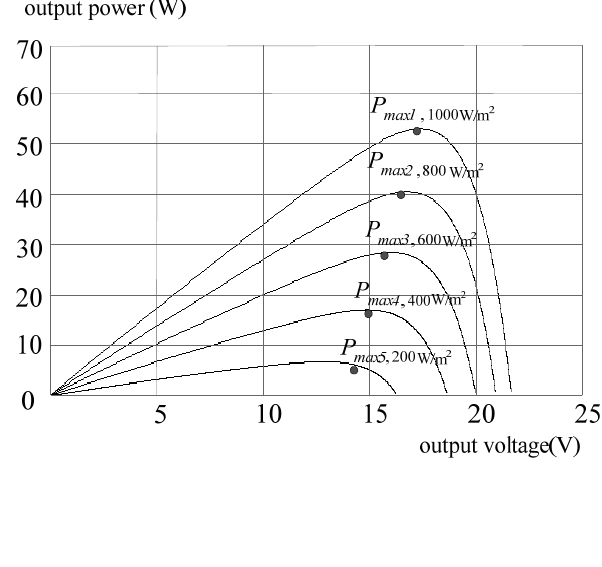
Figure 2. P – V curves of the PV module with constant temperature (25 PV PV